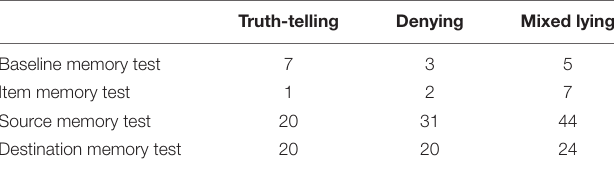
Truth-telling Denying Mixed